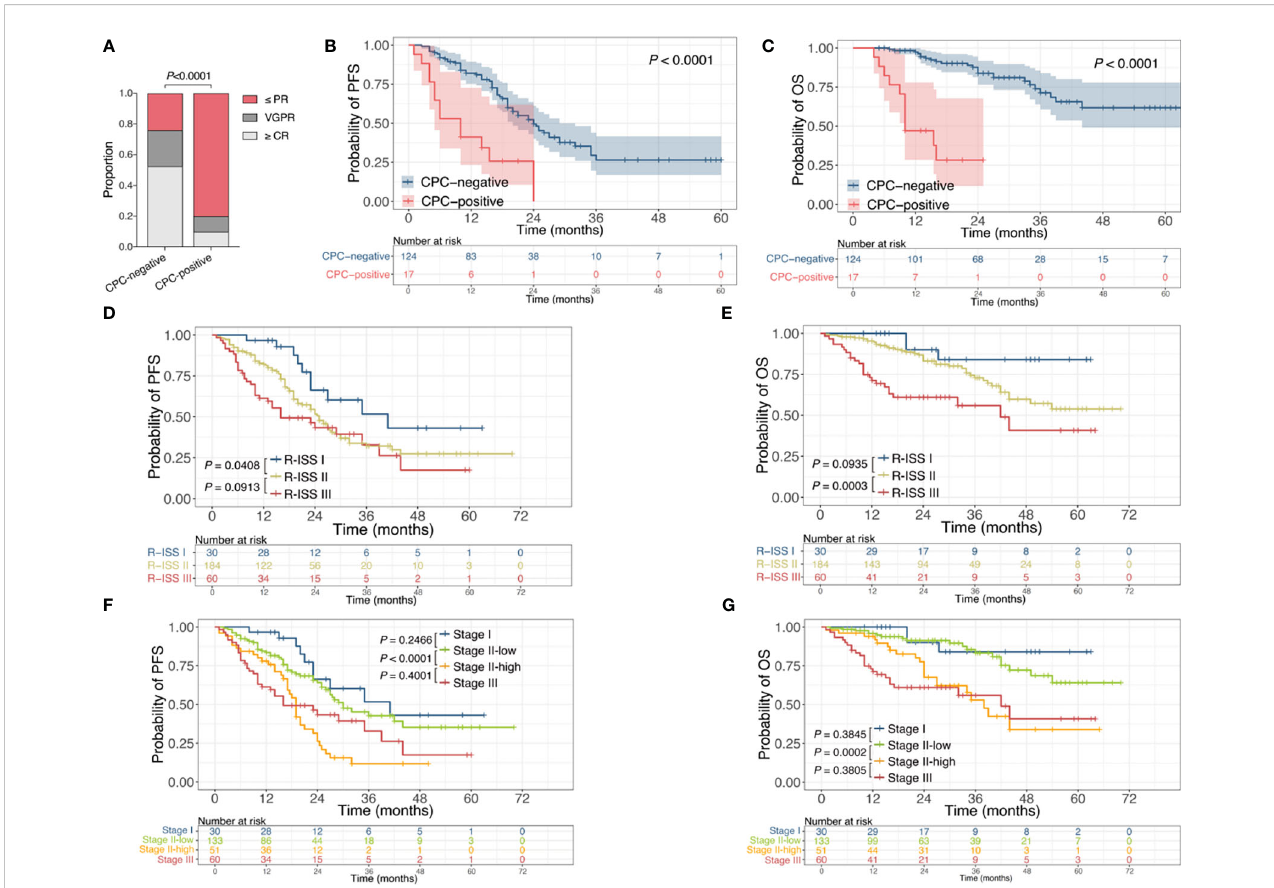
FIGURE 2 Association of post-therapeutic CPC with ef fi cacy and prognosis. (A) Response rates of patients with or without remaining CPC after induction therapy. (B, C) Kaplan-Meier curves for PFS (B) and OS (C) of patients with or without remaining CPC after induction therapy. (D, E) Kaplan-Meier curves for PFS (D) and OS (E) strati fi ed by R-ISS. (F, G) Kaplan-Meier curves for PFS (F) and OS (G) strati fi ed by R-ISS combined with CPC levels. CPC, circulating plasma cells; PR, partial response; VGPR, very good partial response; CR, complete response; R-ISS, revised International Staging System; PFS, progression free survival; OS, overall